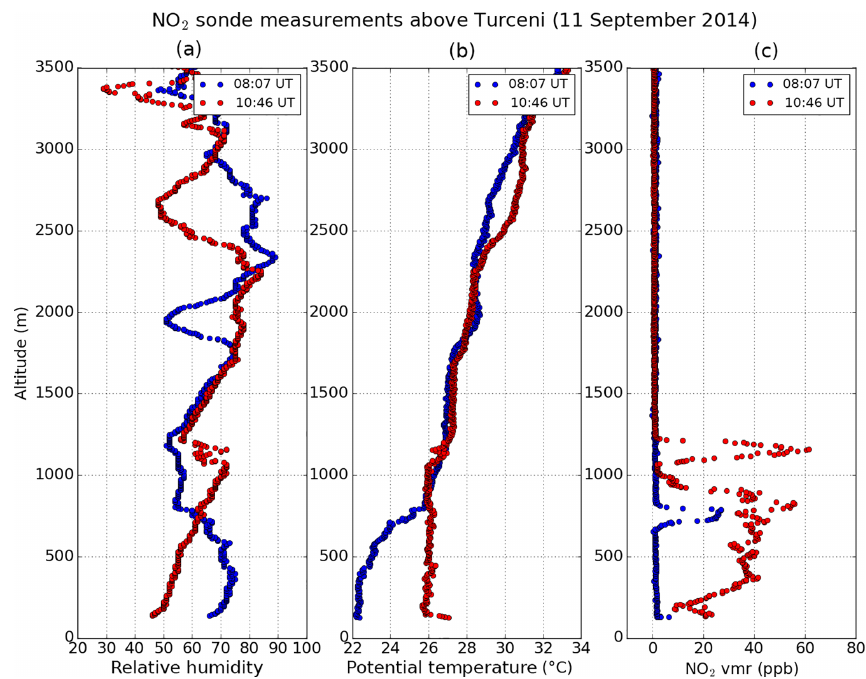
Figure 6. Lower parts of two NO 2 balloon-borne sonde measurements in Turceni on 11 September 2014. Panel (a) presents the profiles of relative humidity during the two soundings, (b) presents the potential temperature profiles, and (c) presents the NO 2